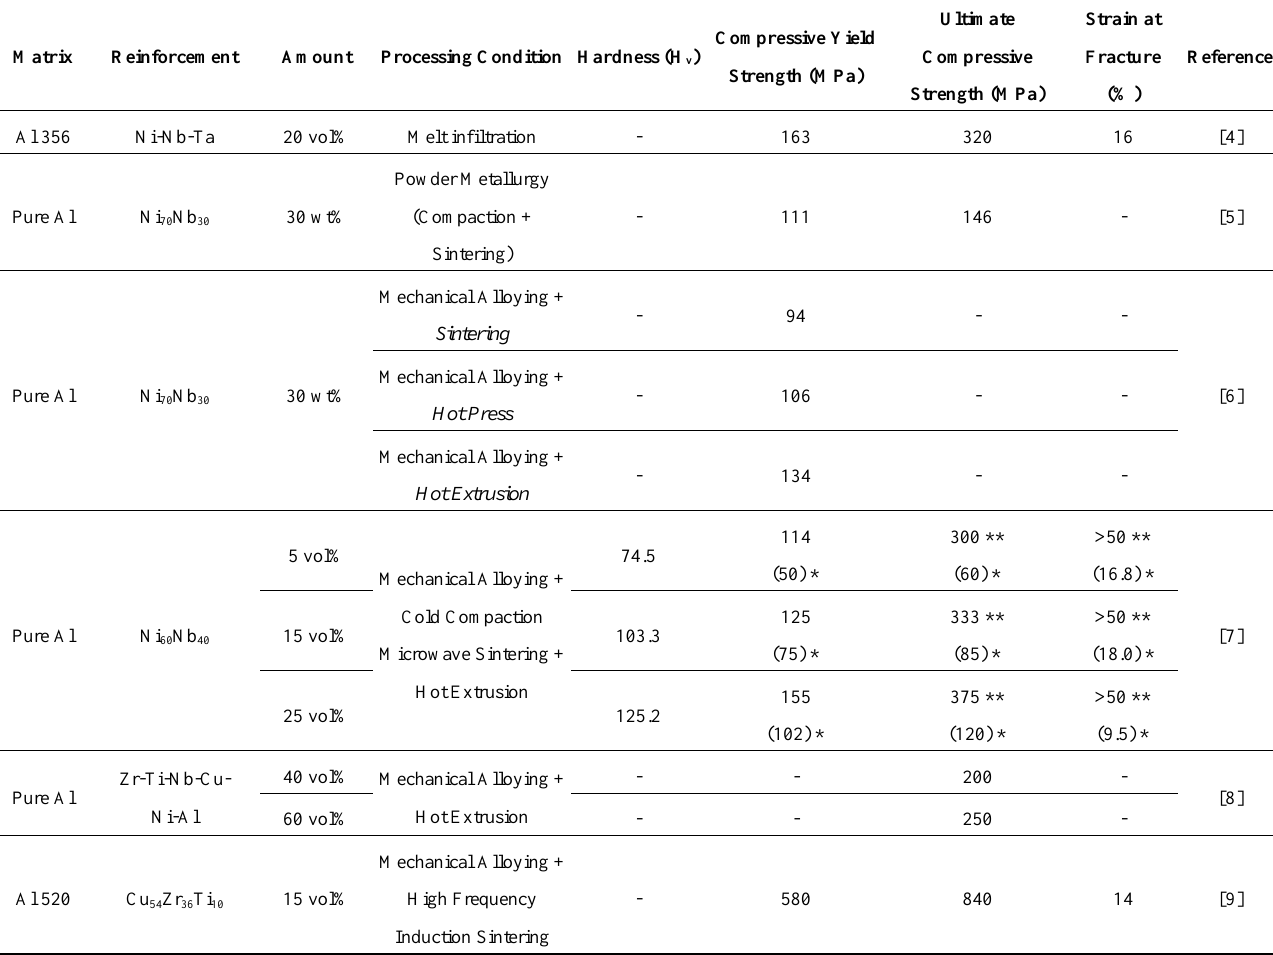
Table 1. Properties of bulk metallic glass (BMG) reinforced